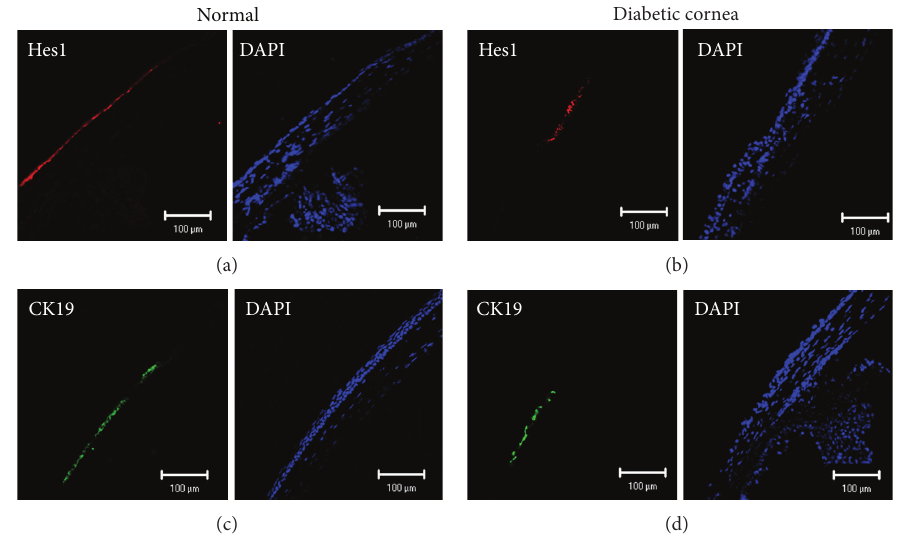
Figure 3: Decreased expression levels of corneal progenitor/stem cell markers in diabetes. Representative immunostained micrographs of the cross-sections of the normal ((a) and (c)) and diabetic ((b) and (d)) corneas showing the expression of stem cell markers. Expression levels of Hes1 (b) and Keratin19 (d) decreased in diabetic eyes after 12 weeks compared with those in the normal eyes ((a) and